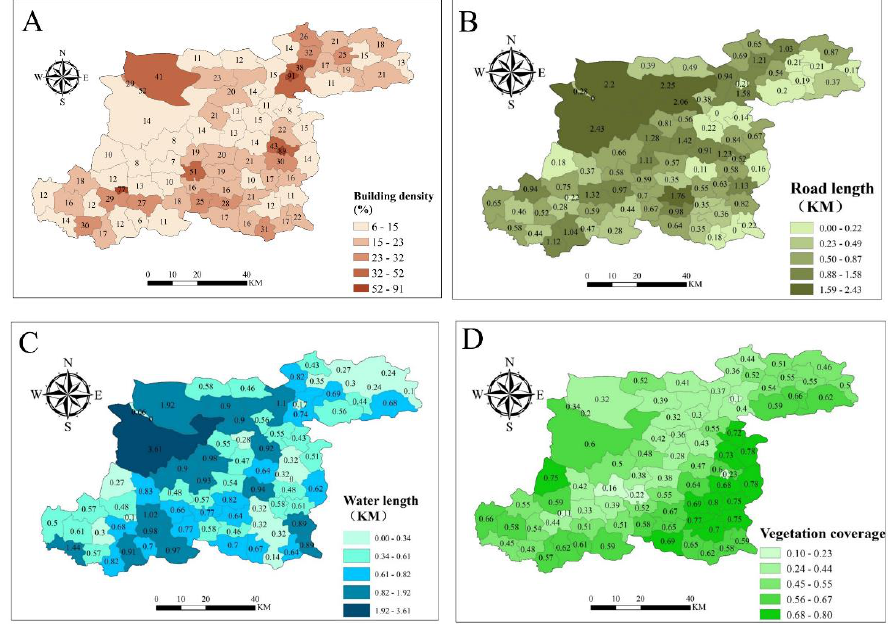
Figure 6. ( A ): Building density of each township in Kaifeng; ( B ): the road network length of each township in Kaifeng; ( C ): the length of the water body in each township of Kaifeng; ( D ): vegetation coverage of towns and villages in Kaifeng.